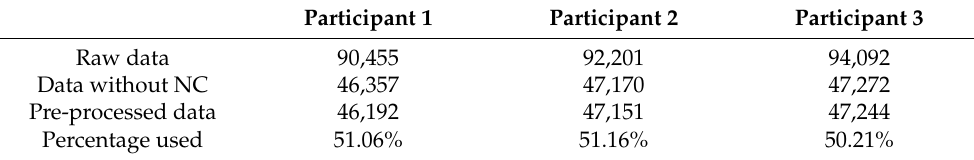
Table 2. Number of samples obtained in each stage of the process and percentage used. Participant 1 Participant 2